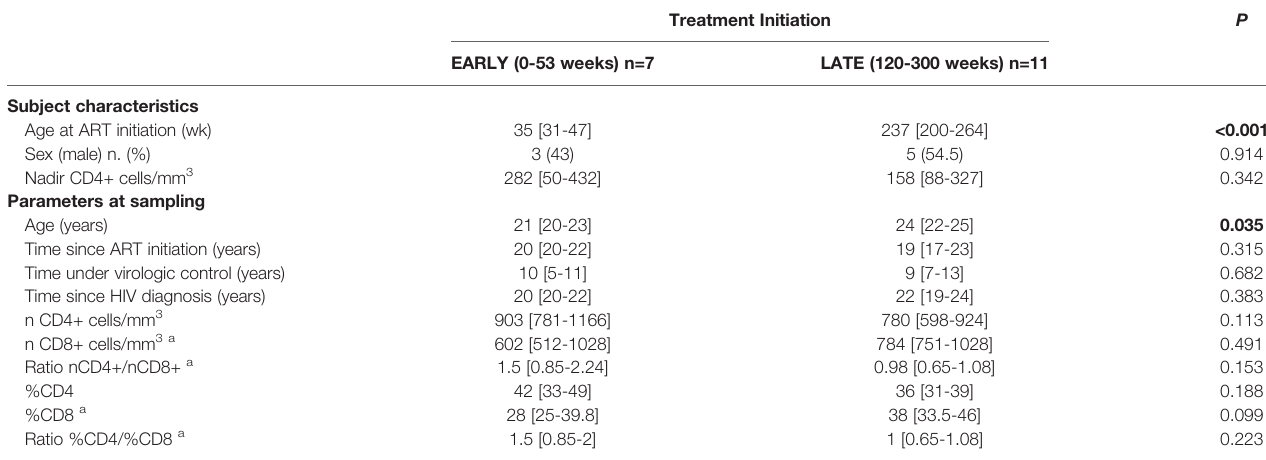
TABLE 1 | Study cohort characteristics.